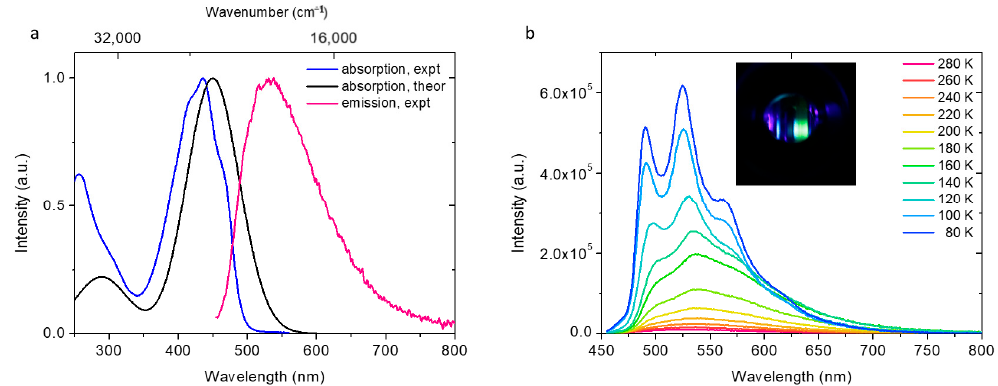
Figure 4. ( a ) Experimental absorption / emission spectra in chloroform and the calculated absorption spectrum. ( b ) Emission spectra at di ff erent temperatures in 2-methyl-tetrahydrofuran and a picture of the irradiated solution of spirostannole 4 (green luminescence) in 2-methyltetrahydrofuran at 80